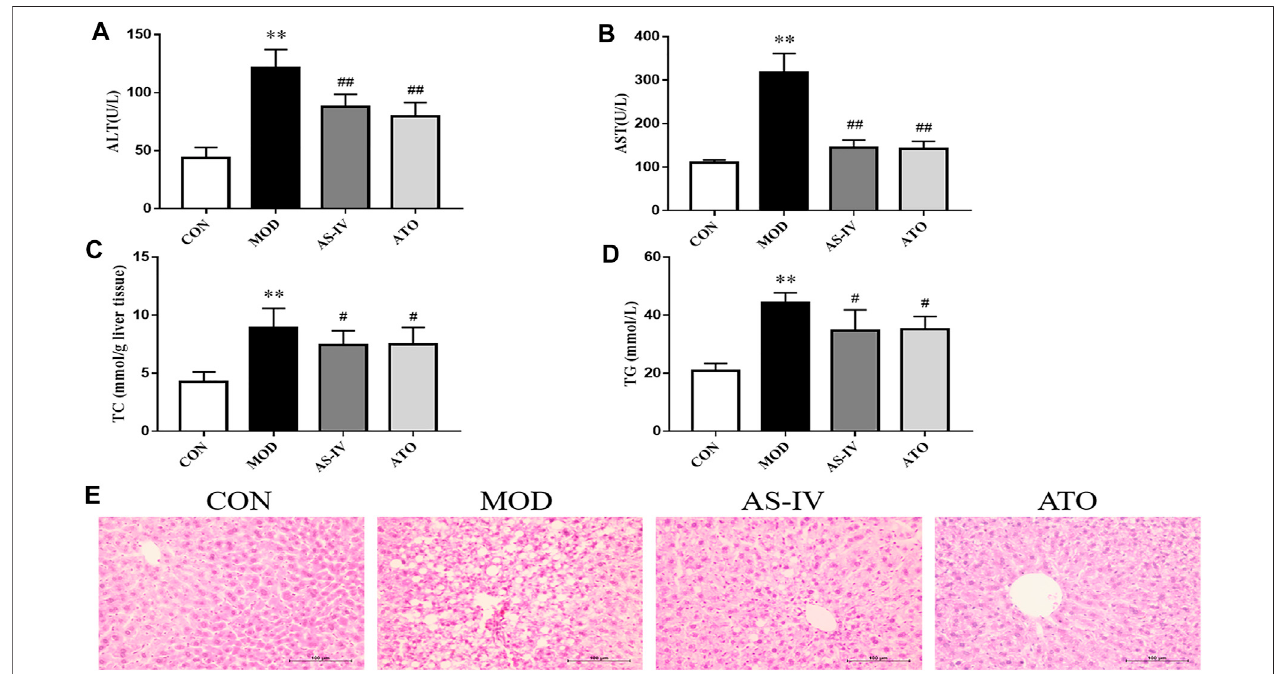
FIGURE 3 | Transaminase, liver lipogenesis and hepatic steatosis in the LDLR − / − mice. (A,B) ALT and AST levels of serum were detected, n = 8. (C,D) Hepatic TC and TG levels were detected by colorimetric enzymatic kits, n = 8. (E) Representative histological change of steatosis in liver sections stained with H&E, magni fi cation ×400.CONmeanscontrolgroup,MODmeansmodelgroup,AS-IVmeansAstragalosideIVgroup,ATOmeansAtorvastatingroup.ALT,alanineaminotransferase;AST, aspartate aminotransferase; TC, total cholesterol; TG, triglyceride. Data are expressed as mean ± SD. ** p < 0.01 versus CON group; ## p < 0.01 versus MOD